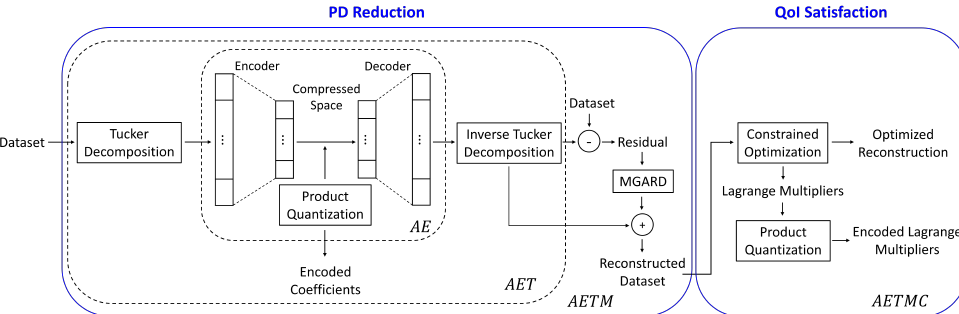
Figure 2. A high-level description of the overall framework. The framework mainly consists of two parts—Primary Data (PD) reduction and Quantities of Interest (QoI) satisfaction. In the PD reduction part, we use Tucker decomposition as a preprocessing step. Then, an autoencoder (AE) compresses the Tucker basis coefficients. After training, a product quantizer (PQ) encodes the AE latent space. AET denotes the combination of Tucker decomposition, an AE, and PQ. MGARD is used for residual post-processing and it provides the guaranteed error bound on PD. AETM is AET followed by MGARD. In the QoI satisfaction step, we run constrained optimization on the reconstructed data via AETM. The purpose of this step is to directly control QoI preservation and obtain the new output, while keeping the change of the PD errors as small as possible. Another product quantizer is used to encode Lagrange multipliers obtained in this step. The overall framework is called AETMC, denoting a combination of AETM and constraint